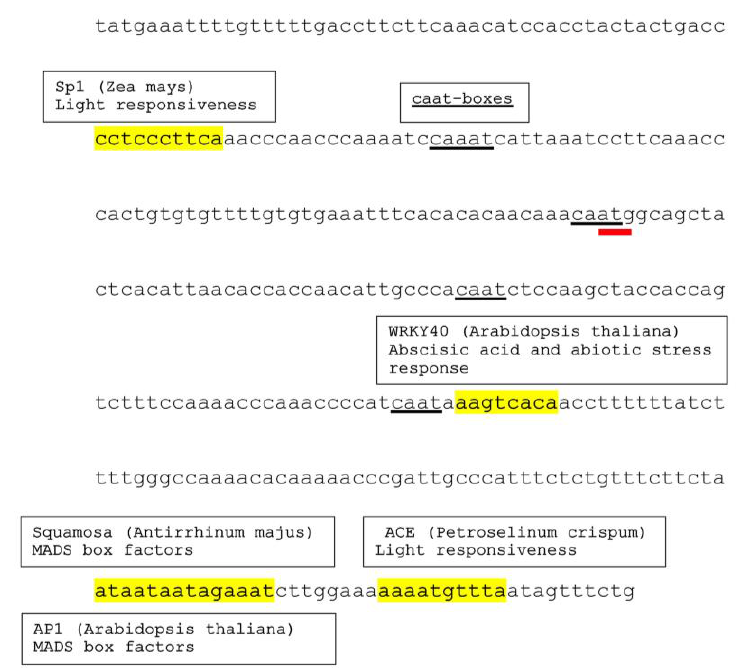
Figure 4. In silico analysis of the DNA sequence of the EPSP - synthase 1 gene of Conyza canadensis . Black solid lines represent the CAAT-boxes and yellow markers represent the elements found in the sequence. The red line represents the translation start site. Sp1: light responsiveness element; WRKY40: WRKY-domain transcription factor, ACE: light responsiveness element; AP1: APETALA 1 transcription factor.